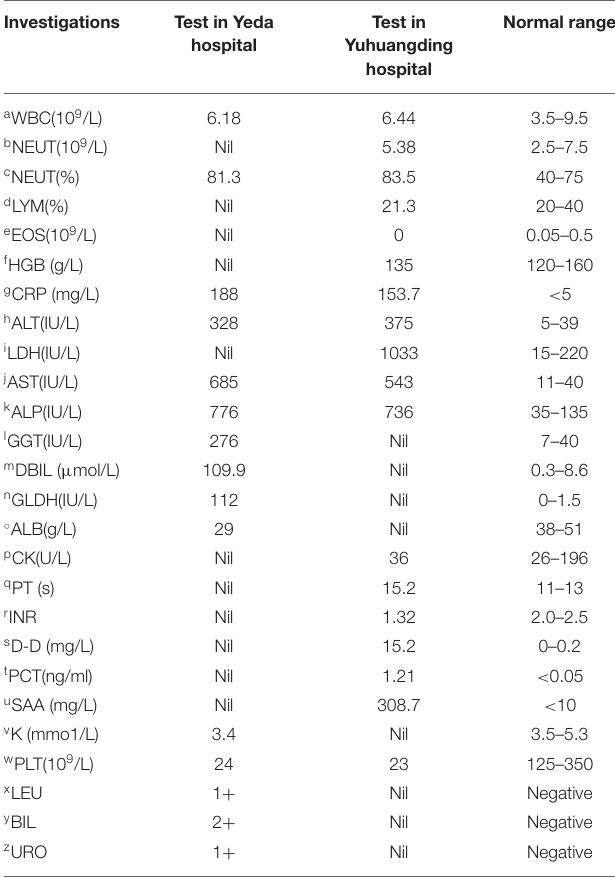
TABLE 1 | Summary of routine blood tests and blood biochemical